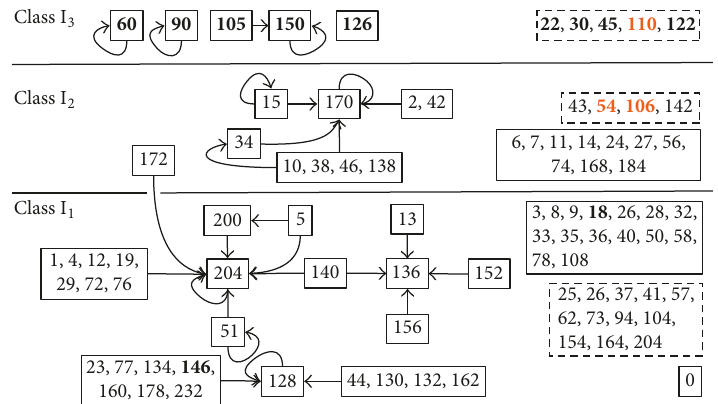
Figure 5: Coarse-graining transitions within ECA found in [1], mapped onto a hierarchy of the information-based classes identified here. Only the 88 rule equivalency classes are shown (represented by the lowest number rule). For simplicity, (nontrivial) transitions to rule zero are not shown (isolated boxed with continuous border). Boxes with a dashed border include ECA rules for which a coarse-graining transition to another ECA rule with supercell of size 4 or less does not exist